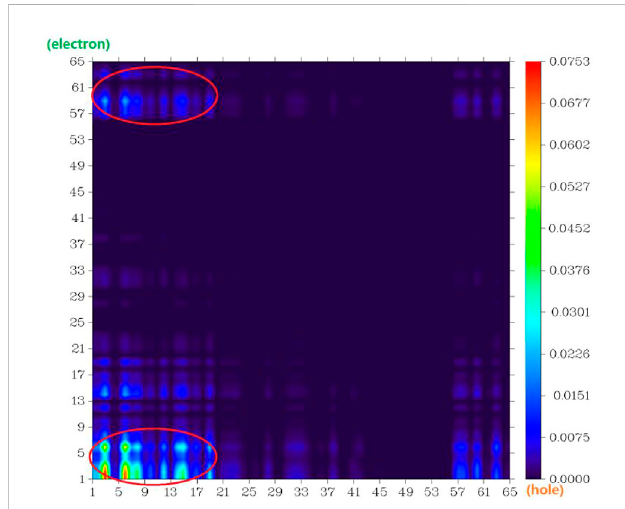
Atom – atomelectrontransferheatmapofDAD-NO(atomnumbers were referred to Figure 1).